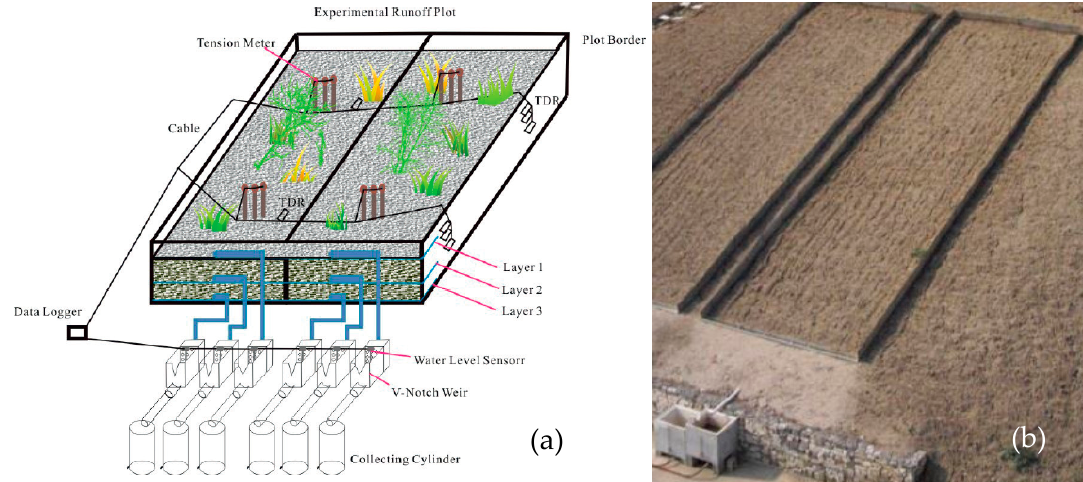
Figure 1. Examples of experimental plots ( a ) for runo ff measurements ( © 2018 Lihu Yang, Xianfang Song and Yunfeng Qiao. Originally published in Water Cycle Process Research [11], under CC BY 3.0 license) and ( b ) for runo ff measurements and sediment yields [6].